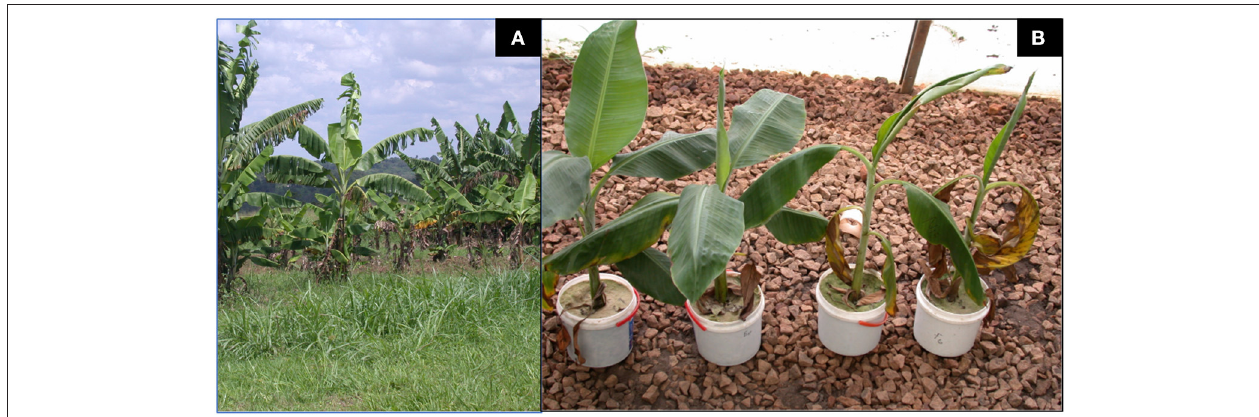
FIGURE 1 | Tissue culture banana plants inoculated with strains of Fusarium oxysporum . (A) An experimental plot of East African Highland Cooking Banana plants (genomic group Musa AAA-EA, cv. Kisansa ) inoculated with wild-type F. oxysporum V5w2 expressing stuntedness and yellowing of leaves flanked by two plots with relatively healthier plants of the same cultivar. The plants had been transferred to the field on 18th January 2007 and the photograph taken 10 months later on 19th November 2007 (Source: Own work). (B) Potted East African Highland Cooking Banana plants (genomic group Musa AAA-EA, cv. Kibuzi ) co-inoculated inoculated with chlorate-resistant F. oxysporum V5w2 and Radopholus similis expressing wilt-like symptoms (2 right) and those inoculated with F. oxysporum V5w2 only (2 left) . All plants were grown in sterile beach sand collected from Lake Victoria and supplied with phosphorus-deficient nutrient solution (Source: Own